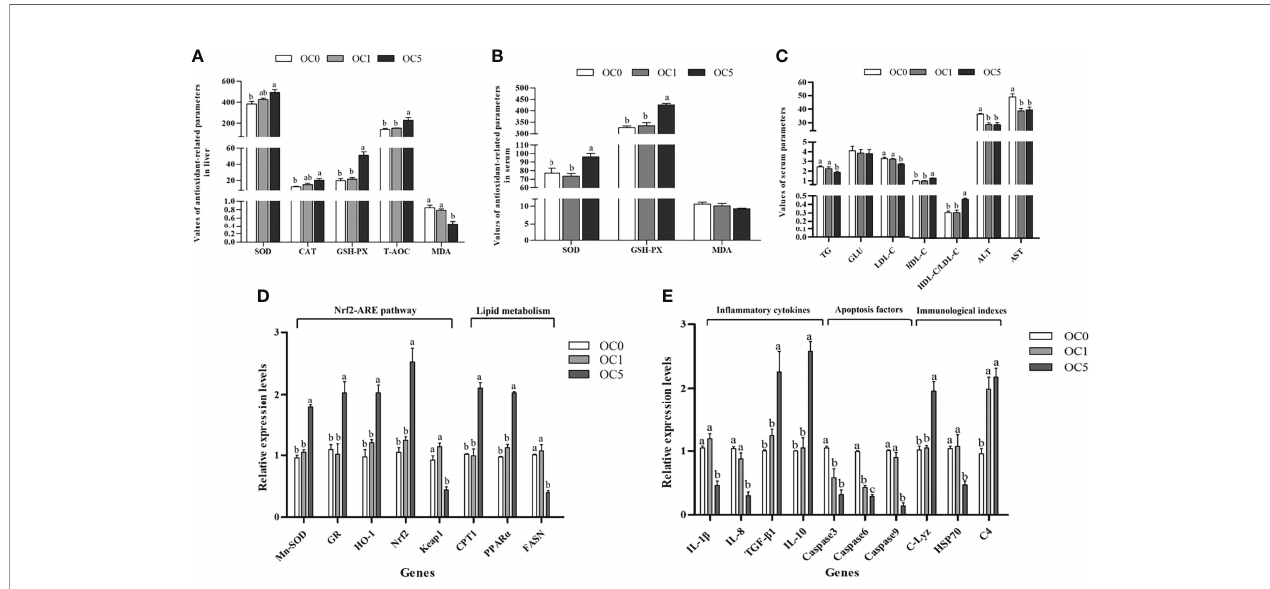
FIGURE 5 | Antioxidant-related parameters in liver (A) or serum (B) , serum biochemical parameters (C) , and relative expression levels of antioxidant-related, metabolism-related, and immune-related genes in the liver (D, E) of T. ovatus fed experimental diets. SOD, superoxide dismutase (U mg protein -1 in liver; U ml -1 in serum); CAT, catalase (U mg protein -1 ); GSH-PX, glutathione peroxidase (U mg protein -1 in liver; U ml -1 in serum); T-AOC, total antioxidant capacity (mmol g protein - 1 ); MDA, malondialdehyde (nmol mg protein -1 in liver; nmol ml -1 in serum); TG, triglyceride (mmol L -1 ); GLU, glucose (mmol L -1 ); ALT, alanine aminotransferase (U L -1 ); AST, aspartate aminotransferase (U L -1 ); LDL-C, low-density lipoprotein cholesterol (mmol L -1 ); HDL-C, high-density lipoprotein cholesterol (mmol L -1 ). Mn-SOD, manganese superoxide dismutase; GR, glutathione reductase; HO-1, hemeoxygenase-1; Nrf2, NF-E2-related nuclear factor 2; Keap1, Kelch-like-ECH-associated protein 1; C-Lyz, c-type lysozyme; HSP70, heat shock protein 70; C4, complement 4; IL-1 b , interleukin 1 b ; IL-8, interleukin 8; TGF- b 1, transforming growth factor b 1; IL-10, interleukin 10; CPT1, carnitine palmitoyl transferase 1; PPAR a , peroxisome proliferator-activated receptors-alpha; FASN, fatty acid synthesis. Values were presented as mean ± SE (n = 3). The small letters indicated signi fi cant differences at P <